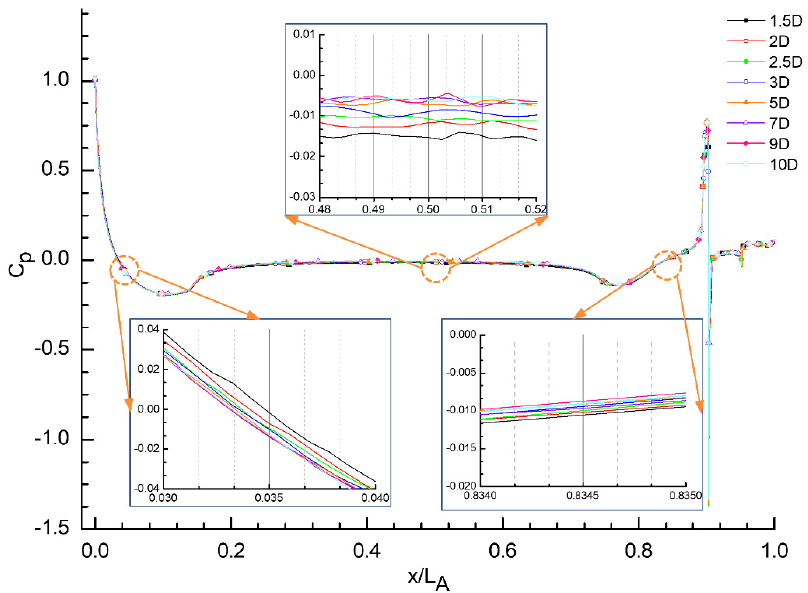
Figure 9. (cid:1829) (cid:1868) distribution of bare UUV at cross section a for different Hd. Figure 9. C p distribution of bare UUV at cross section a for different Hd